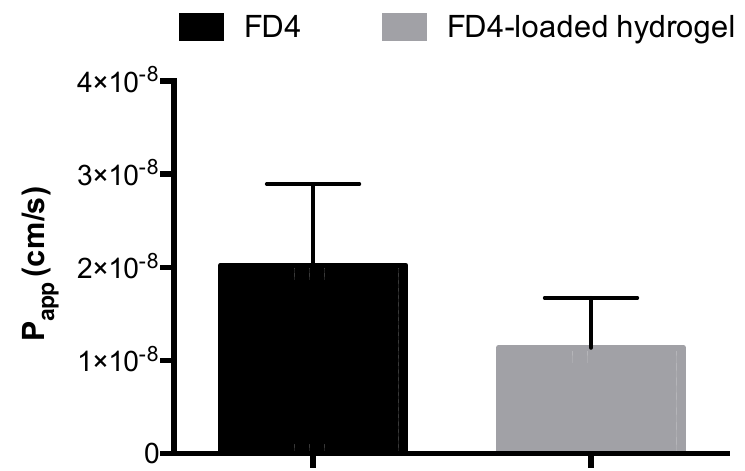
Figure 5. Permeability of fluorescein isothiocyanate (FITC)-labelled dextran of ~4 kDa (FD4) when applied to Caco-2 monolayers in solution (‘FD4’) or loaded in hydrogel (‘FD4-loaded hydrogel’). Hydrogel formulated from 5% w / v ascorbyl palmitate. Data shown as the mean ± SD ( n = 3, p > 0.05).